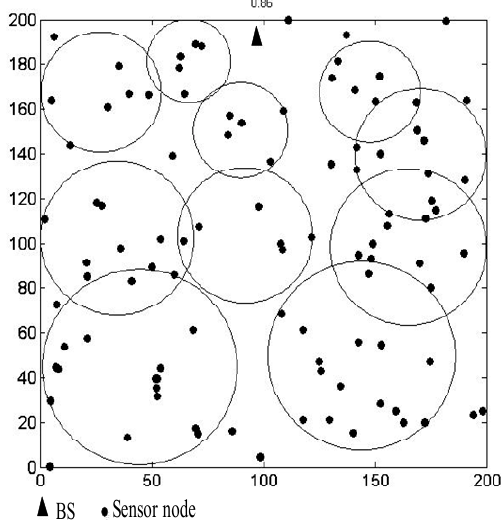
Figure 8. The circular area ( IoU < 0.7) distribution of the proposed algorithm in the simulation experiment.